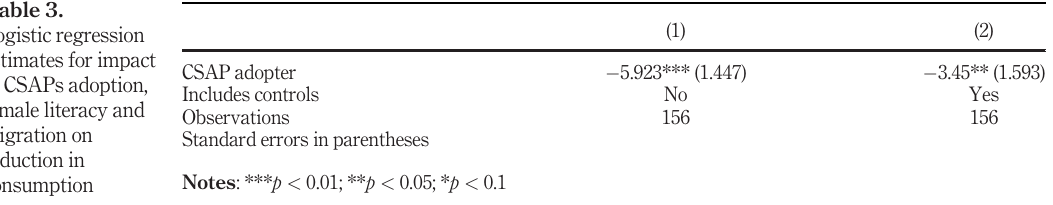
Table 2. Logistic regression estimates for the impact of CSAPs